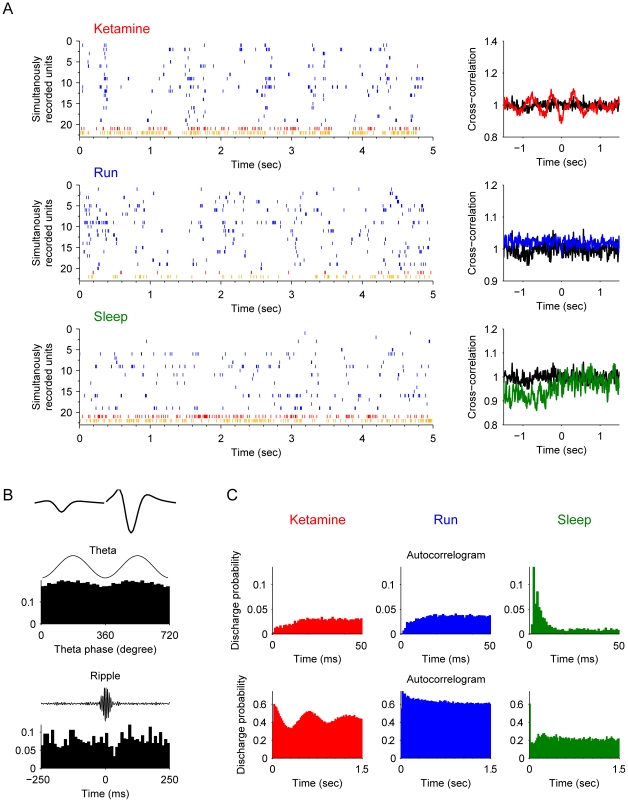
Properties of type-6 interneurons.(A) Spike rasters of silmultanously recorded pyramidal cells (blue) and type-6 interneurons (red unit is plotted for B and C) during ketamine anesthetic state, running, and slow-wave sleep are shown (left subpanels). Other two simultaneously recorded type-6 interneurons are in orange. The cross-correlation functions of the interneuron and pyramidal cell joint-activities are plotted on the right. The black line is the cross-correlation during the awake rest state. (B) The basic properties. The most upper left panel shows the average spike waveforms. Firing probability histograms during theta and ripples are shown in middle left and lower left panels respectively. (C) Autocorrelograms in different states: after ketamine injection, during running, and during sleep respectively. Autocorrelograms are shown in two time scales: 0–50 ms and 0–1.5 sec. Note the slow oscillatory dynamics are shown in both the cross-correlation plot and the larger time scale autocorrelogram after ketamine injection. This unit exhibits a burst firing pattern during sleep shown in the peak within 10 ms in the autocorrelogram.